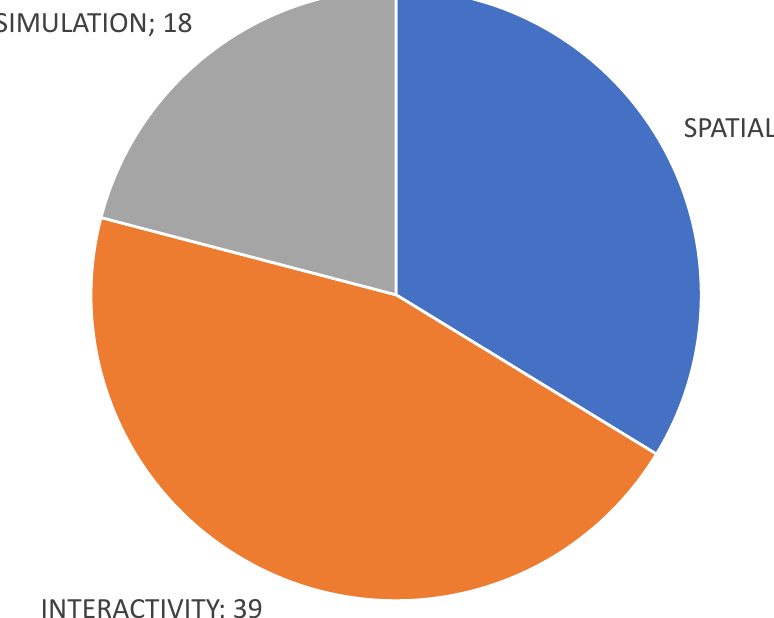
Figure 9. The number of times spatial vision, interactivity, and simulation were exploited in the works analyzed.